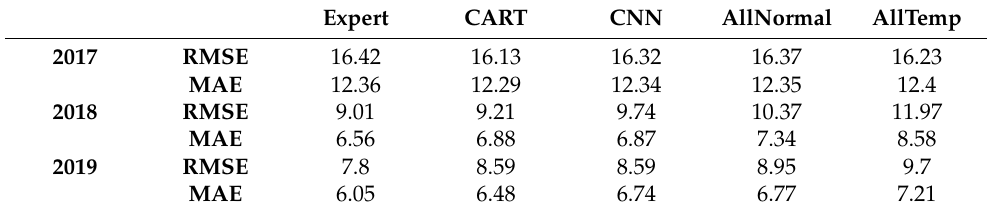
Table 2. PM 2.5 forecast performance of various model strategies with short-term training in five days. Expert